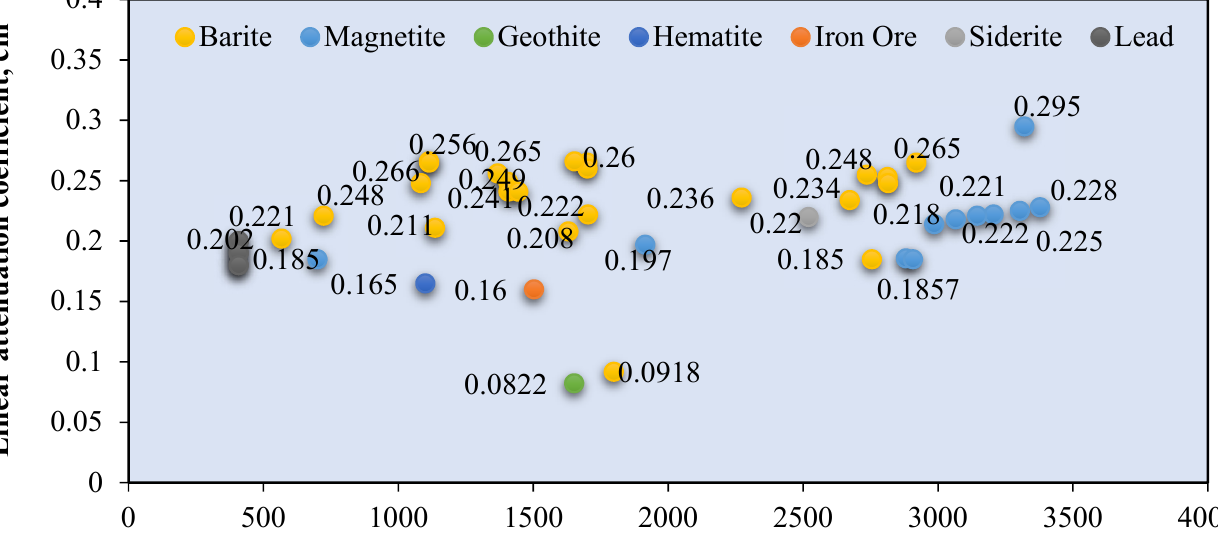
Figure 7. Relationship between linear attenuation coefficient (cm − 1 ) and the amount of heavyweight minerals in concrete (kg/m 3 ) (data adapted from [12,14,18,29,44,45,53,63,67,88,106,120,123]).